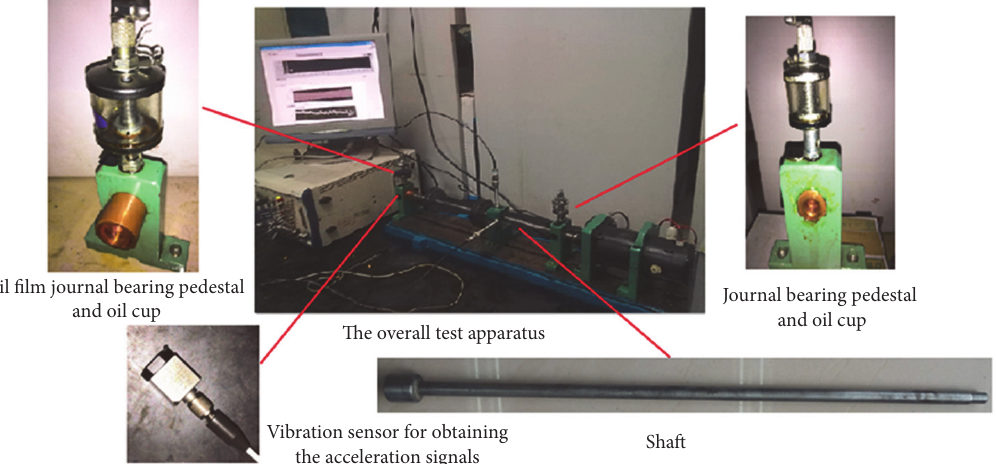
Figure 1: Test rig and its main components.